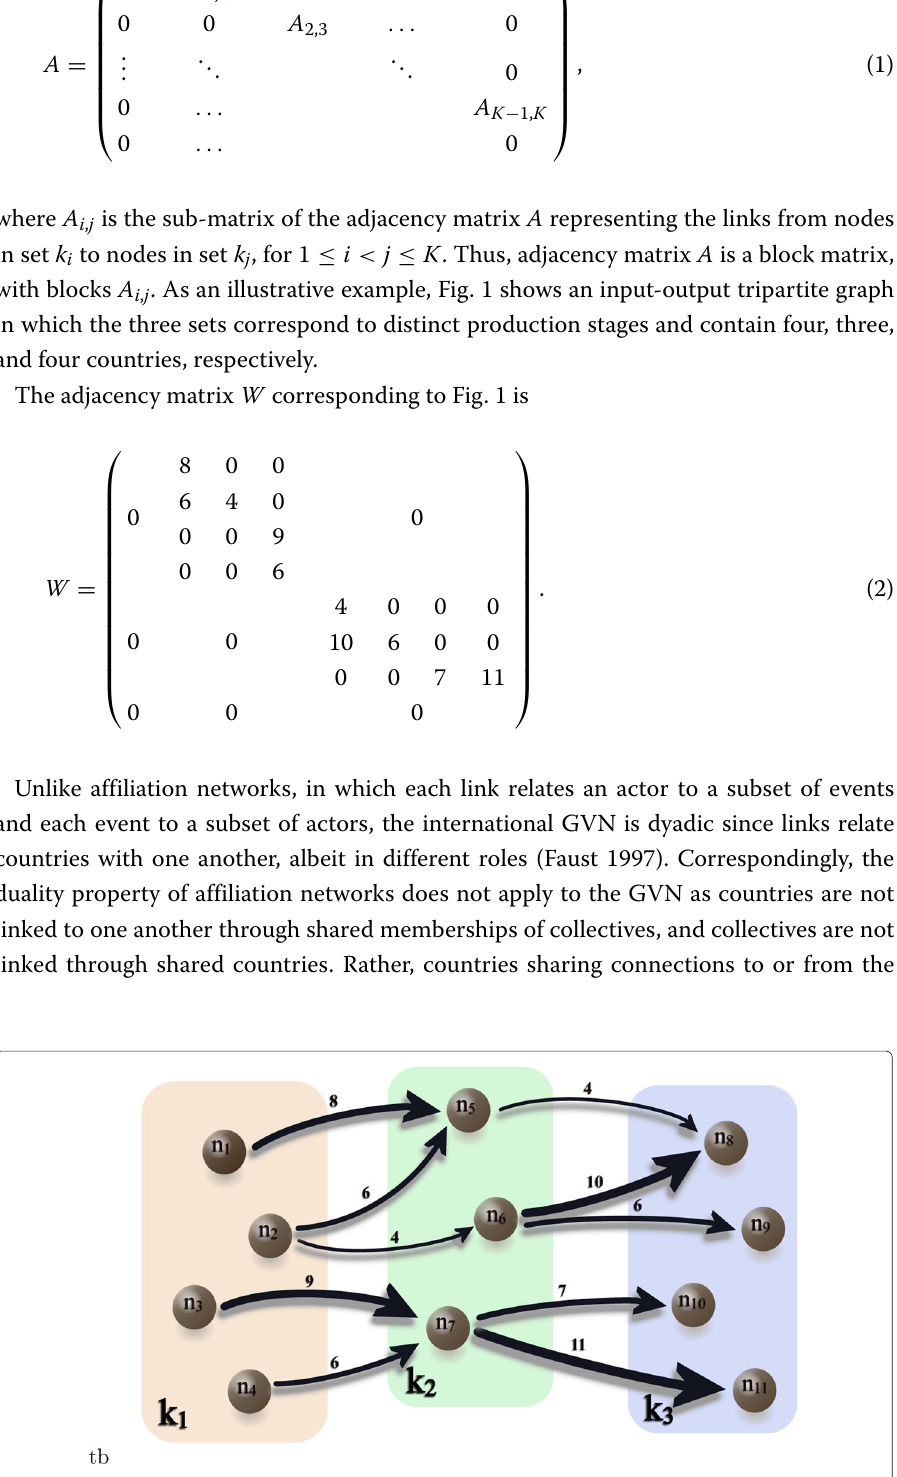
Fig. 1 Example of an input-output tripartite weighted graph. The sets k 1 , k 2 , and k 3 represent three production stages. Only links from nodes in set k 1 to nodes in set k 2 and links from nodes in set k 2 to nodes in set k 3 are allowed. Above each link is indicated the value of its corresponding weight. The width of each link is proportional to the corresponding